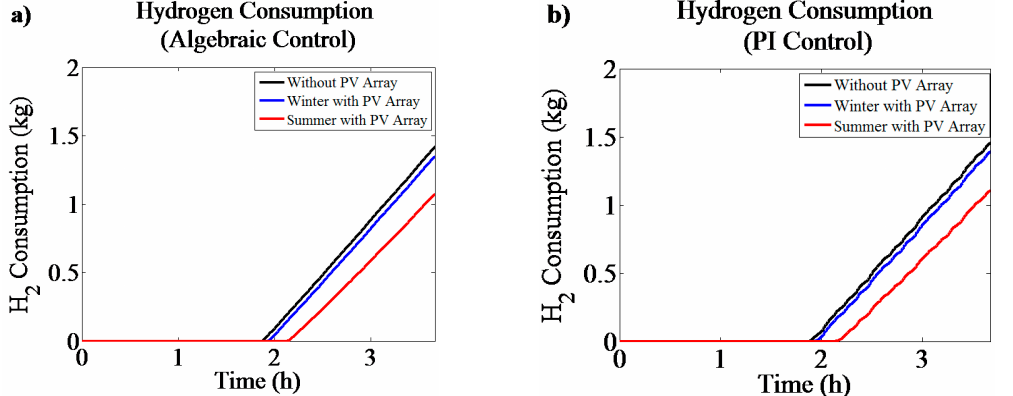
Figure 8. Hydrogen consumption profile of the PV/fuel cell/battery bus operation